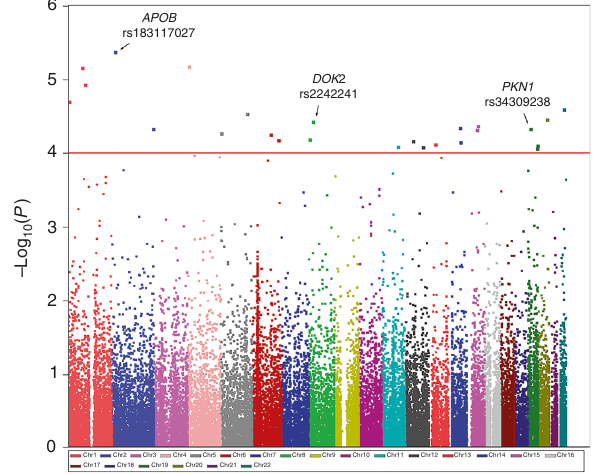
Fig. 1 Manhattan plot for associations between genetic variants and pancreatic cancer risk. A total of 43,045 variants that passed the quality control and with MAF > 0.1% in controls were analysed and plotted. The associations ( – log 10 ( P ) values, y axis) are plotted against genomic position ( x axis by chromosome and the chromosomal position of NCBI build 37). The red horizontal line corresponds to a P value threshold of 1.00 × 10 − 4